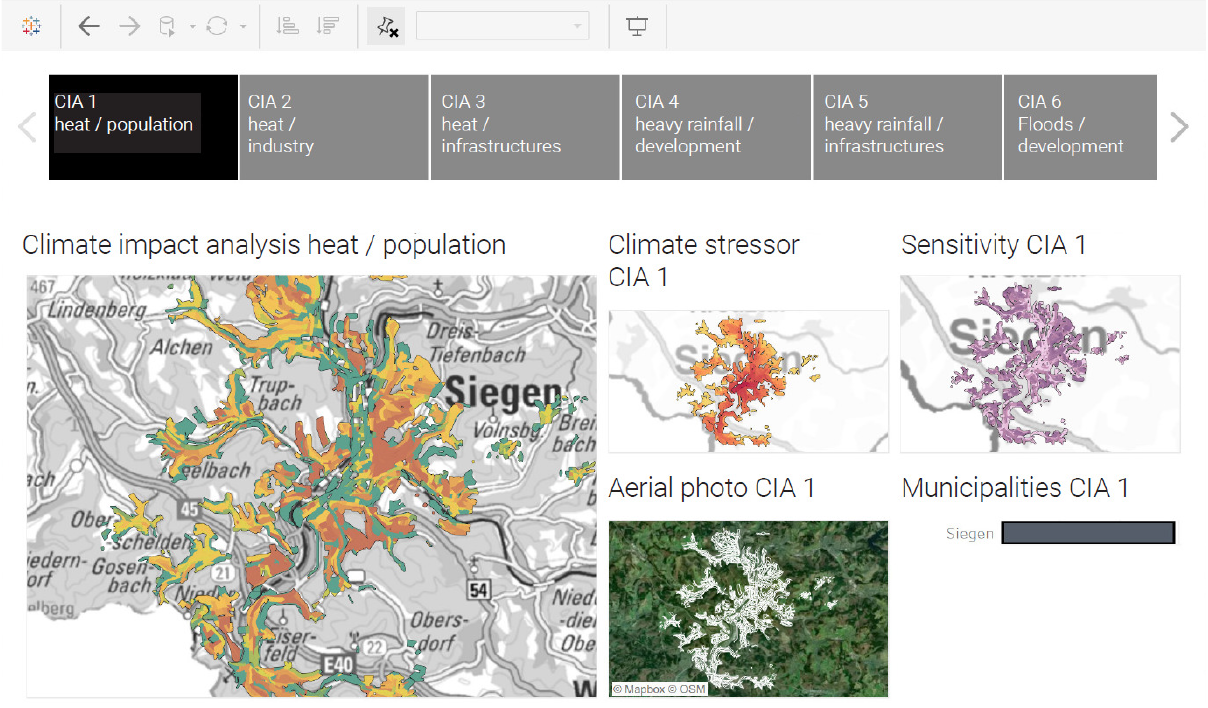
Figure 4. ER regions: Intersection of climate stressors and sensitivity, example heat, and population. Source: Schmitt and Wright